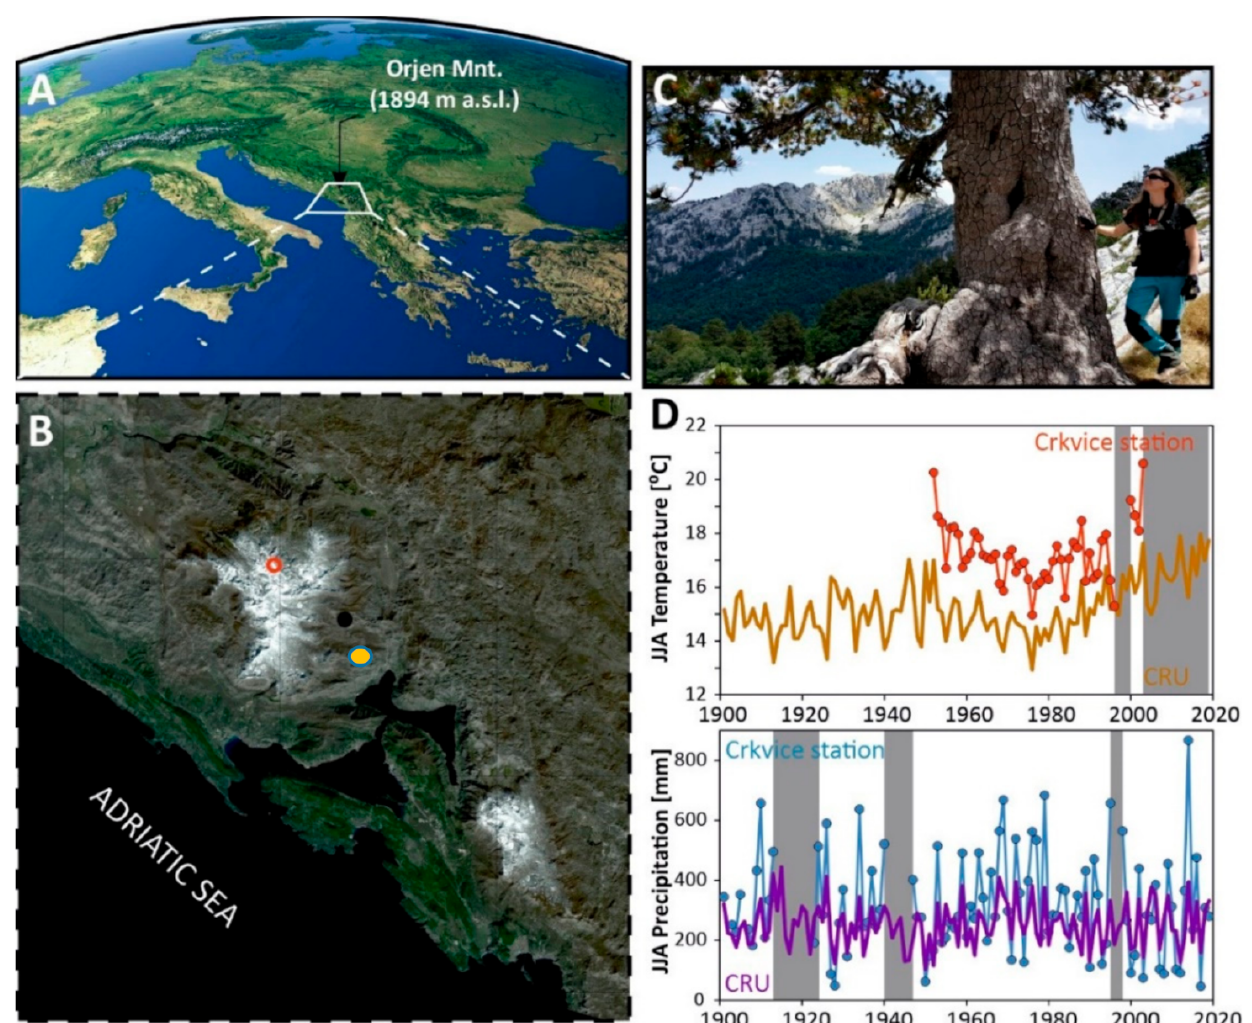
Figure 1. ( A ) Geographical position of the research area. ( B ) Satellite image of the Orjen Mountains. Red circle indicates the location of the Orjen Peak. Yellow point indicates the location of Crkvice meteorological station. ( C ) Example of an old pine tree on the sample plot. ( D ) Comparison of average summer (JJA) temperature and precipitation trends from the local meteorological station (Crkvice, 940 m a.s.l.) and gridded (0.5 × 0.5 ◦ grid) CRU TS3.24.01 data. Shaded areas indicate gaps in the climatological observations over the period of